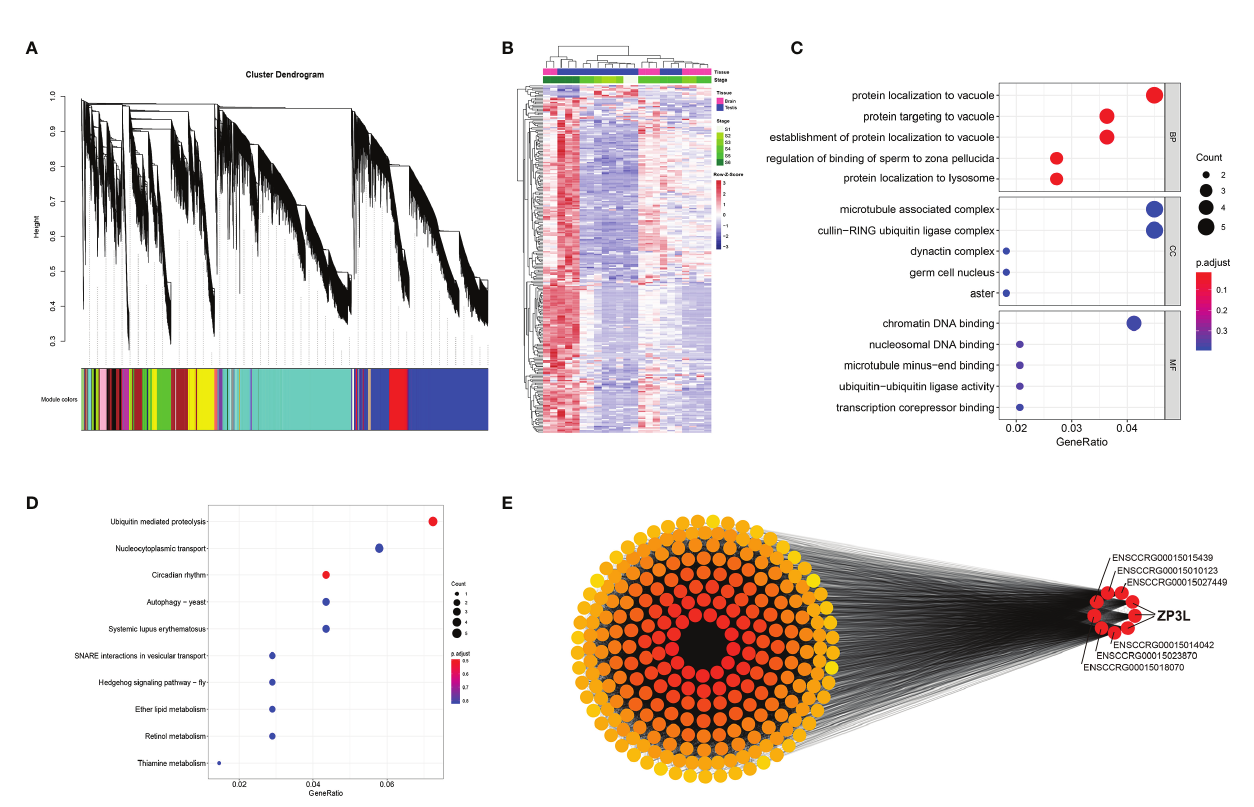
FIGURE 6 | Weighted gene co-expression network analysis (WGCNA) reveals discrete gene networks across testicular development. (A) WGCNA cluster dendrogram of time series samples identi fi ed genes that were assigned into co-expression modules. Based on similarities in module gene expression, hierarchical cluster tree with showing 33 modules of co-expressed genes. Each of the 48336 genes is represented by a leaf in the tree, and each of the 33 modules by a major tree branch. The lower panel shows modules in designated colors, such as ‘ Blue ’ , ‘ Pink ’ , ‘ Turquoise ’ , and others. Genes within the gray-shaded boxes were not assigned to a module. (B) Cluster analysis of genes from the most signi fi cant module. Heatmap showing FPKM expression level of these genes. (C) The GO enrichment analysis of genes from the most signi fi cant module. (D) The KEGG enrichment analysis of genes from the most signi fi cant module. (E) Cytoscape representation of co-expressed genes from the ‘ lightcyan ’